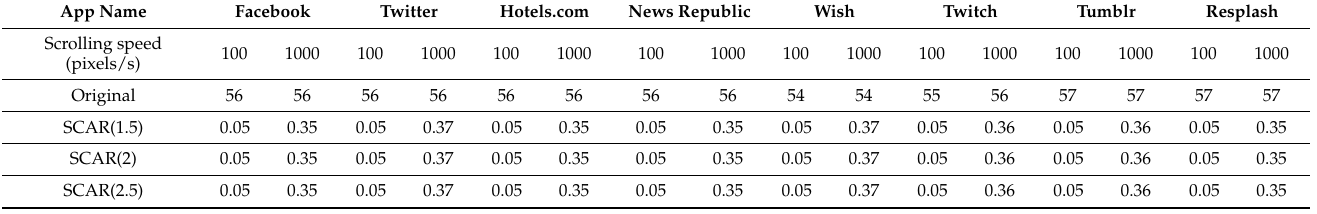
Table 2. Frame rate (fps) according to apps and scrolling speed.